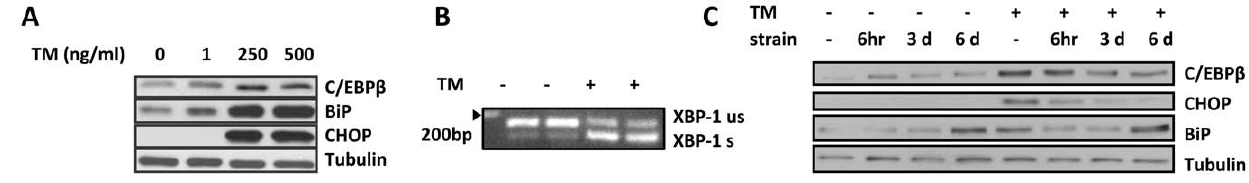
Figure 5. Mechanical strain ameliorates tunicamycin-induced ER stress in MSC. A, mdMSC were cultured in the presence of tunicamycin (TM) at indicated doses for 6 hours and analyzed via immunoblot for C/EBP b , BiP and CHOP. B, as in (A) mdMSC cultured in the presence of tunicamycin 1 m g/ml for 6 hours and analyzed via conventional PCR for XBP1. C, C3H10T1/2 cells were seeded on the same day and treated with mechanical strain for the indicated number of days. Tunicamycin (TM) was added for the final 6 hours prior to protein analysis (representative blot, n=3).